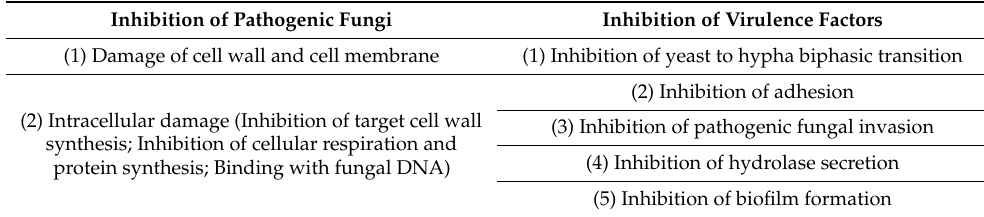
Table 1. Possible mechanism of antifungal metabolites inhibiting C. albicans